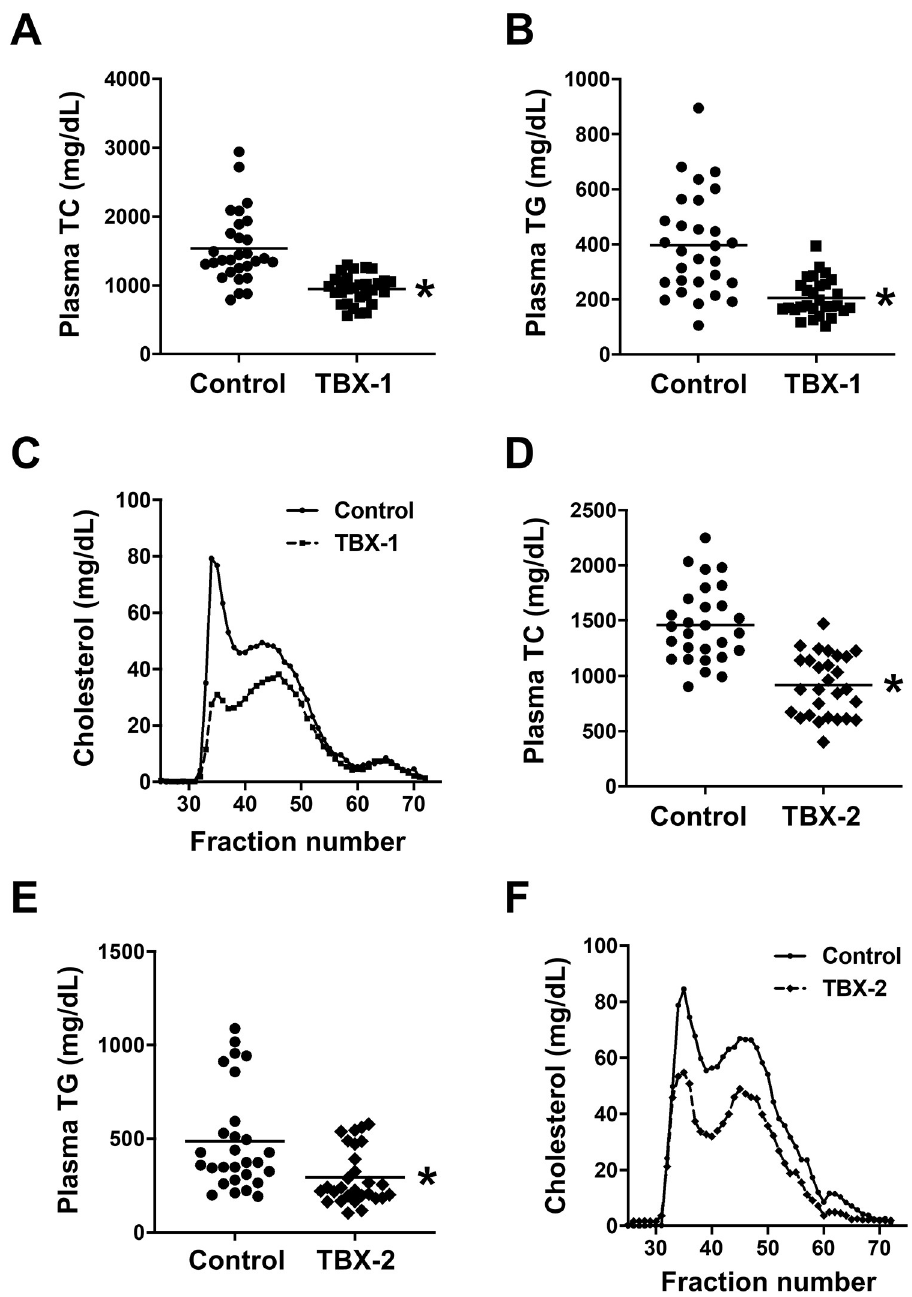
Fig 2. MK2 inhibitor treatment lowers plasma lipids in WD-fed Ldlr -/- mice. Plasma total cholesterol (TC) and triglyceride (TG) levels were measured, and fast protein liquid chromatography-separated lipoproteins were assayed for cholesterol, in Ldlr -/- mice treated with TBX-1 ( A-C ) or TBX-2 ( D-F ) as in Fig 1 (n = 29 mice/group for TBX-1 and n = 28 mice/group for TBX-2; mean ± SEM, p < 0.001, p < 0.001, p < 0.001 and p = 0.002, respectively).